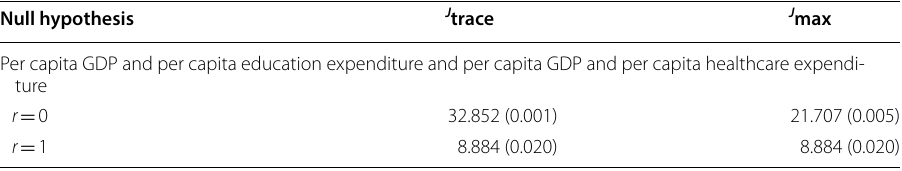
Table 5 Results of co-integration test between per capita GDP, education and healthcare